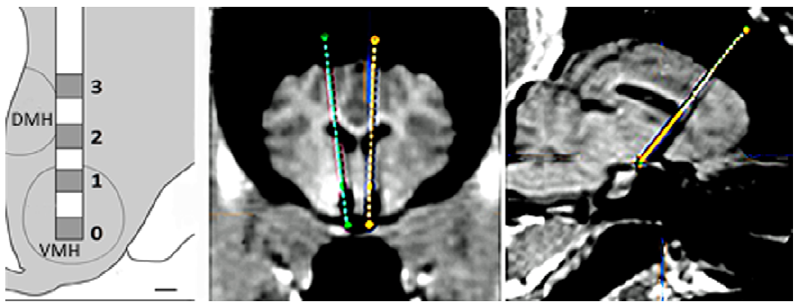
Figure 3. Schematic of DBS lead placement in VMH: Fusion of pre-operative targeting with post-operative MR images. Left: Custom- made DBS leads (O.D. 0.64 mm), were scaled to size for use in the minipig and implanted bilaterally in the VMH regions. The anatomy schematic (adapted from [42] show a coronal hemisection depicting the area of the VMH region occupied by one DBS lead and the relative location of the most distal contact that was used for monopolar stimulation (scale bar=500 m m). Middle and Right: The pre-operative MR scan was fused to the post- operative MR scan to verify accurate bilateral placement of the 2 DBS leads into the VMH. Images are shown in coronal and sagittal planes. The pre- operative scan was used to plan the DBS lead trajectories which are represented by the dotted lines. The post-operative scan shows the DBS leads (in black) which have distorted volumes due to MR artifact.